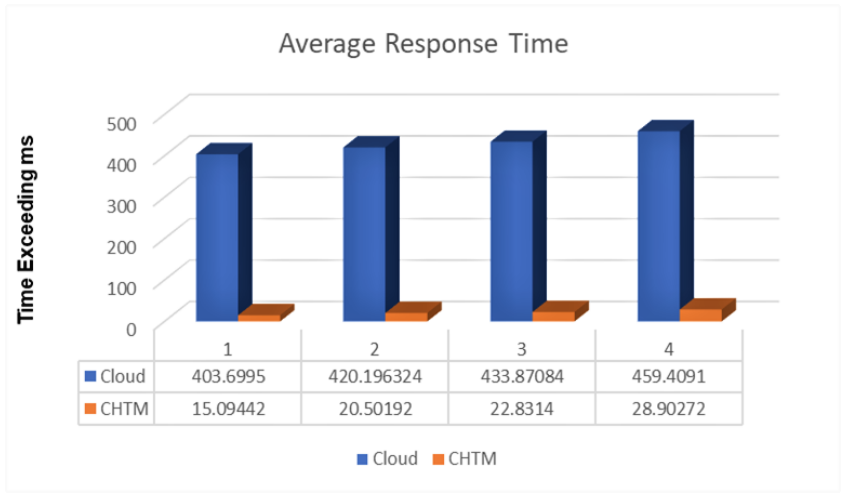
Figure 6. Average response time